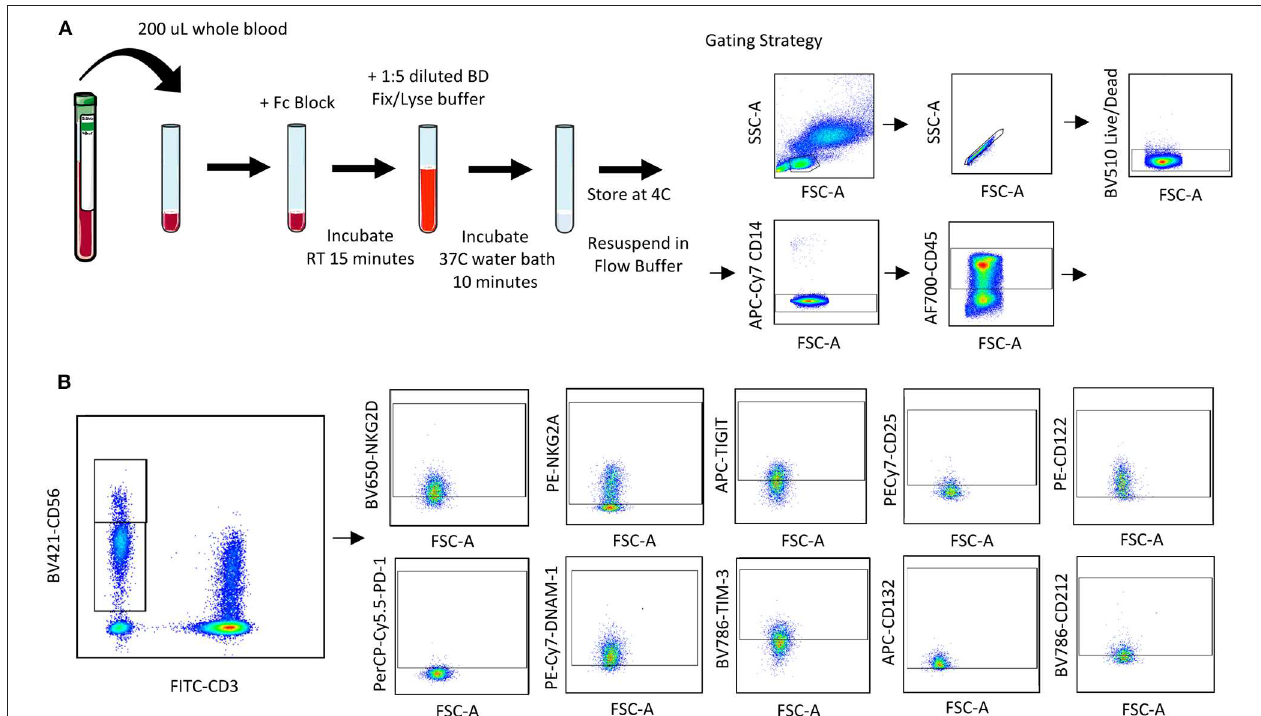
FIGURE 1 | Whole blood receptor methodology and gating strategy. Whole blood was collected from patients and 200 µ L was aliquoted per receptor panel. After a 15-min incubation with the receptor panel, lyse/fix buffer was added and incubated for 10min before blood was spun down, cells were washed and resuspended to be assessed by flow cytometry. The lymphocyte population was gated on before excluding doublets and dead cells (A) . CD45 + CD14 − CD56 Bright / Dim CD3 − cells were gated on to assess activating/inhibitory receptor and cytokine receptor expression based on isotype staining (B) .